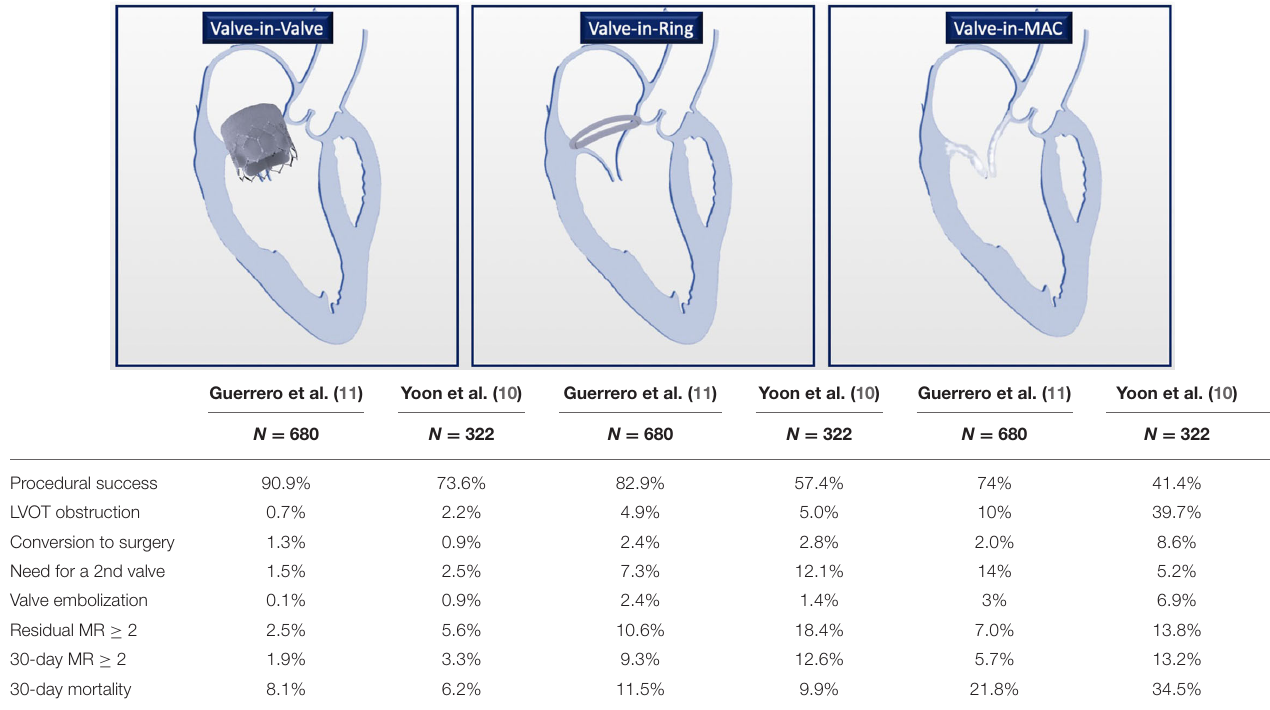
TABLE 1 | Main clinical outcomes for valve-in-valve (ViV), valve-in-ring (ViR), and valve-in-mitral annular calcification (ViMAC).